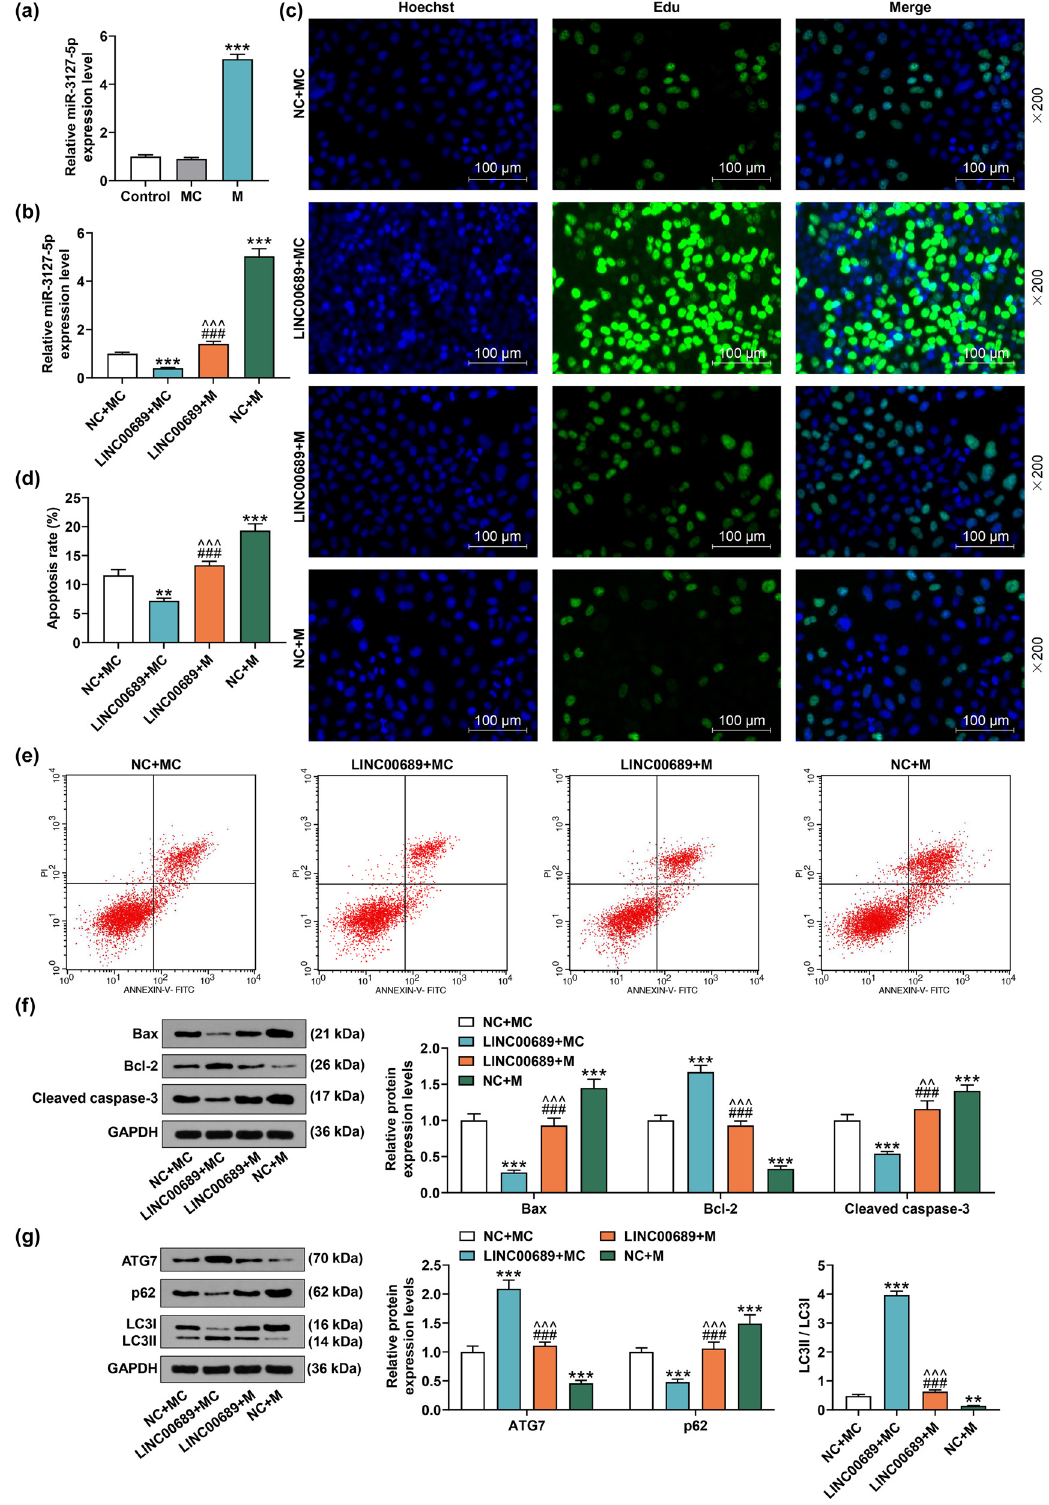
Figure 5: Up - regulation of miR - 3127 - 5p reversed the e ff ect of overexpressed LINC00689 on promoting the proliferation and autophagy, and on inhibiting the apoptosis of NPCs. ( a and b ) The expression of miR - 3127 - 5p in transfected NPCs was analyzed using the qRT - PCR. ( c ) The proliferation of NPCs was measured by EdU staining ( under 200 × magni fi cation, scale bar = 100 μ m ) . ( d and e ) The apoptosis of NPCs was detected by fl ow cytometer. ( f ) The expressions of apoptosis - related factors ( Bax, Bcl - 2, and Cleaved caspase - 3 ) in transfected NPCs were examined using the Western blot. ( g ) The levels of autophagy - related proteins ( ATG7, p62, and LC3 Ⅱ /LC3I ) in transfected NPCs were analyzed by the Western blot. ** P < 0.01, *** P < 0.001 vs MC ( Figure 5a ) or NC + MC ( Figure 5b – g ) ; ^^ P < 0.01, ^^^ P < 0.001 vs LINC00689 + MC; ### P < 0.001 vs NC + M. ( LINC00689: long non - coding RNAs LINC00689, NPCs: human nucleus pulposus cells, M: miR - 3127 - 5p mimic, MC: mimic control, NC: negative control, ATG7: autophagy related 7 )